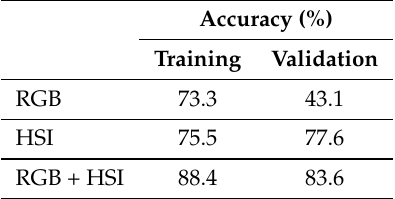
Table 2. Accuracy for training and validation set using individual and fused data